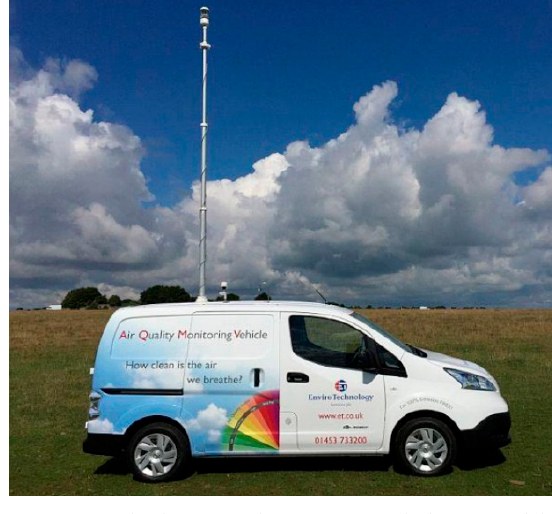
Figure 1. Enviro Technology air quality monitoring vehicle (Smogmobile, source [13]).